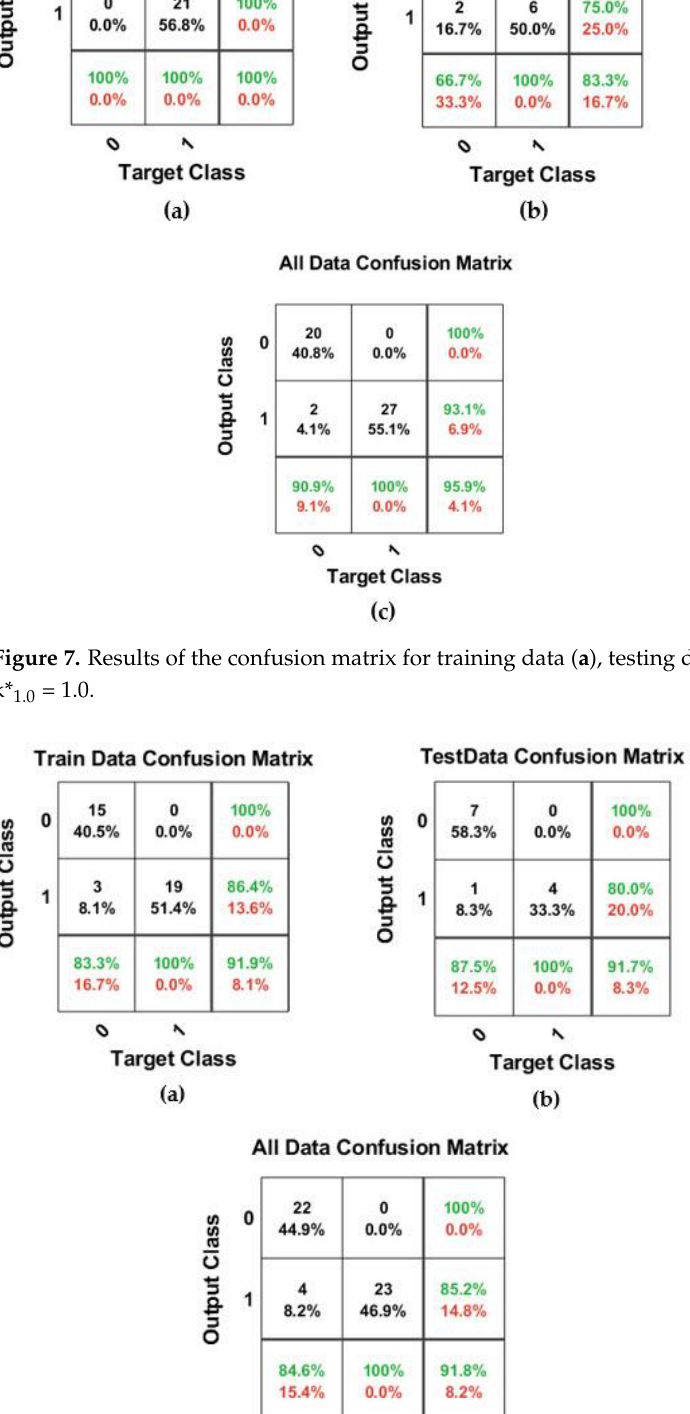
Figure 8. Results of the confusion matrix for training data ( a ), testing data ( b ), and total data ( c ) for k* 1.8 = 1.8.